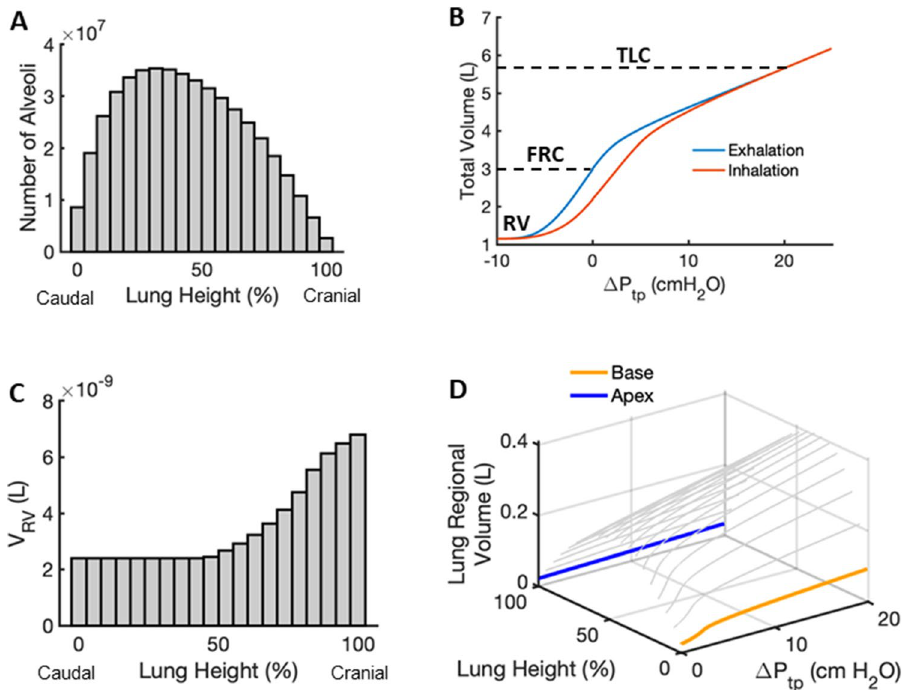
Figure 5. ( A ) Distribution of alveolar numbers in 20 regions versus lung height from base (caudal) to apex (cranial). ( B ) Total lung pressure volume curve during inhalation (red) and exhalation (blue). Residual volume (RV), functional residual capacity (FRC) on the deflation limb, and total lung capacity (TLC), defined respectively as the lung volumes at (cid:31) P tp = − 7, 0, and 20 cmH 2 O, are also indicated. ( C ) Residual volume distribution versus lung height from base to apex. ( D ) 3D plot of regional lung P–V curves versus lung height from base (orange) to apex